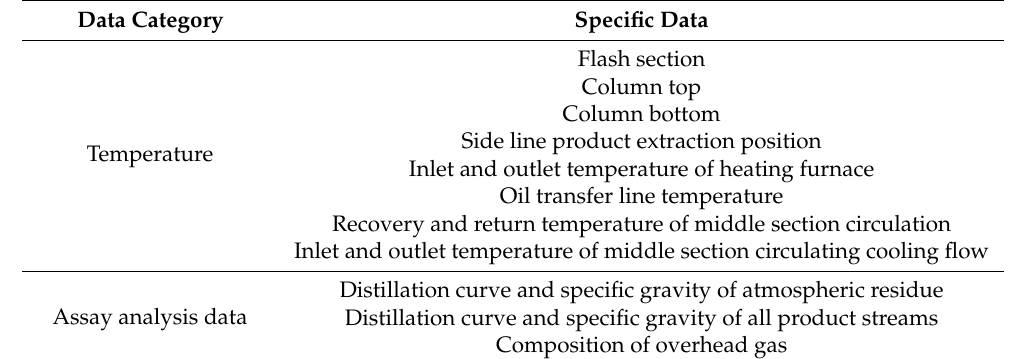
Table 1. Cont. Data Category